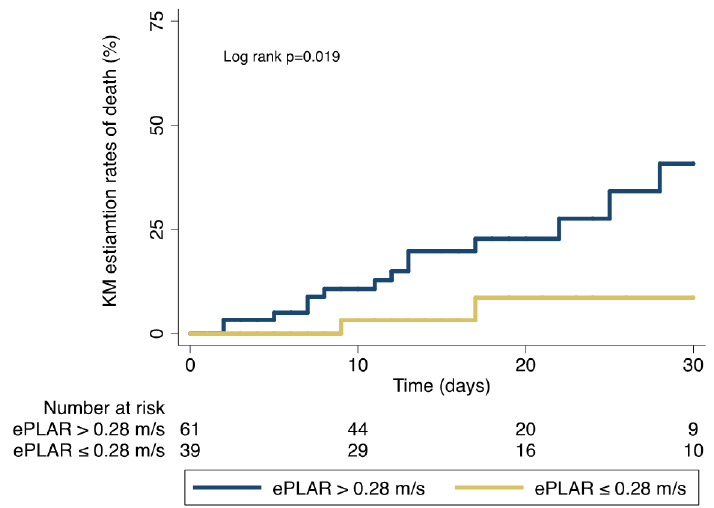
Figure 2. 30-day all-cause death in patients with COVID-19 with high vs. low ePLAR. Kaplan–Meier curves show the estimation rates of death in patients with high vs. low ePLAR value at baseline (cut-off 0.28 m/s); ePLAR = echocardiographic Pulmonary to Left Atrial Ratio.